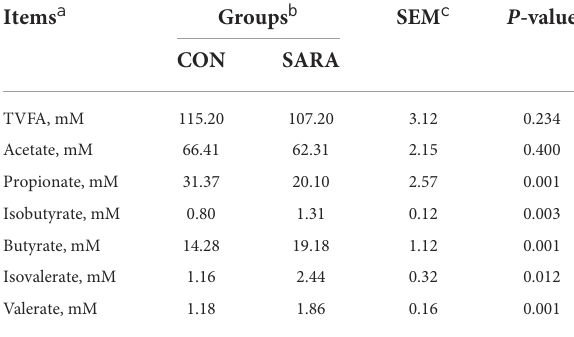
TABLE 6 Effect of subacute rumen acidosis on rumen fermentation parameters in vitro